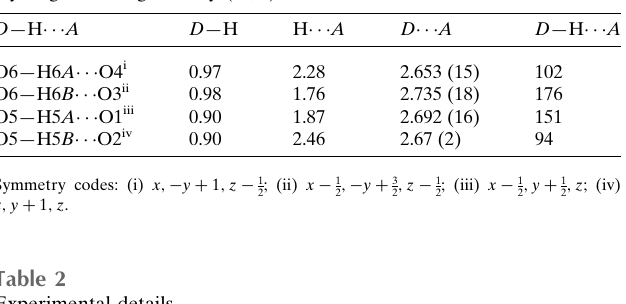
Table 1 Hydrogen-bond geometry (A˚ , (cid:4) ).